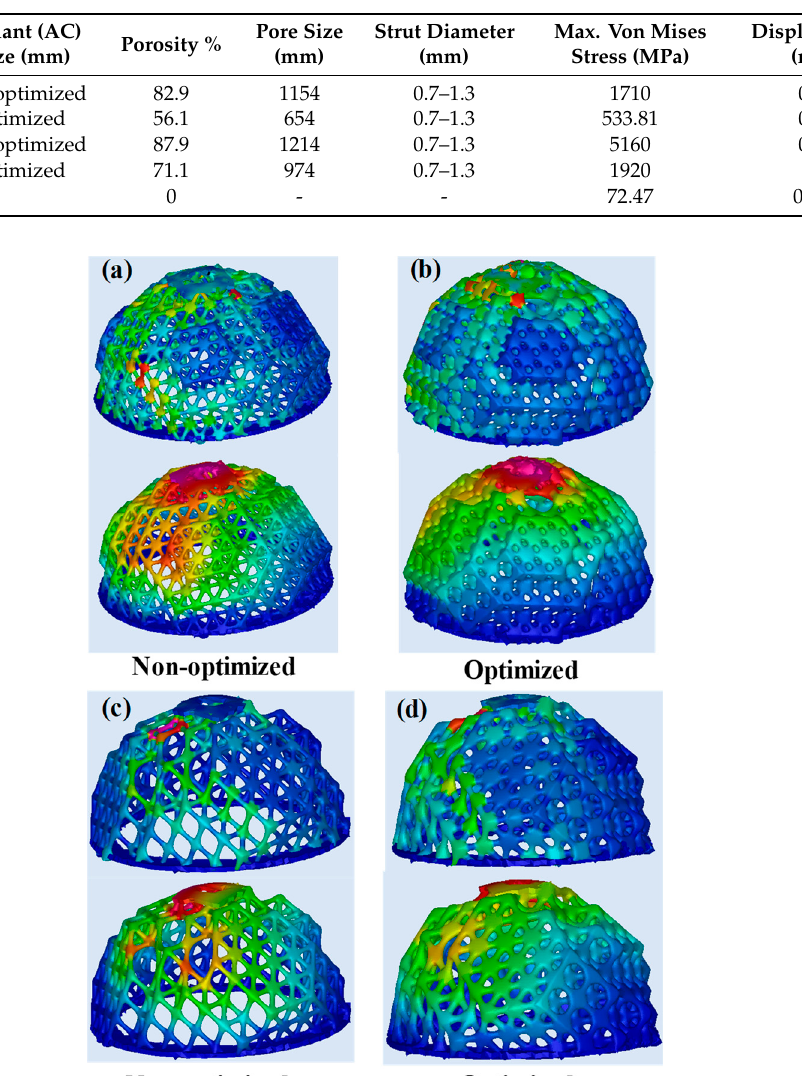
Figure 9. Results of FEA ( a ) unit cell size 5 × 5 × 5 mm non-optimized, ( b ) 5 × 5 × 5 mm optimized, ( c ) 6 × 6 × 6 mm non-optimized, and ( d ) 6 × 6 × 6 mm optimized.